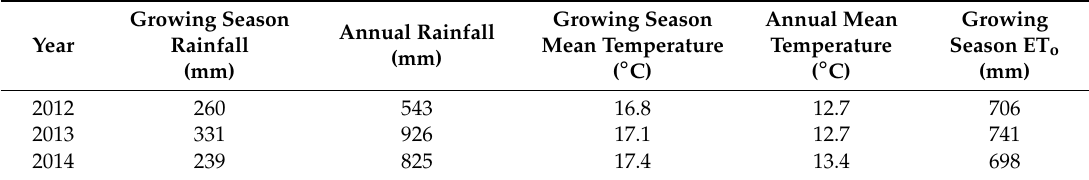
Table 1. Mean temperature, potential evapotranspiration (ET o ) and rainfall over the growing season (April to harvest), and annual rainfall and mean temperature of each year (2012–2014) in the studied